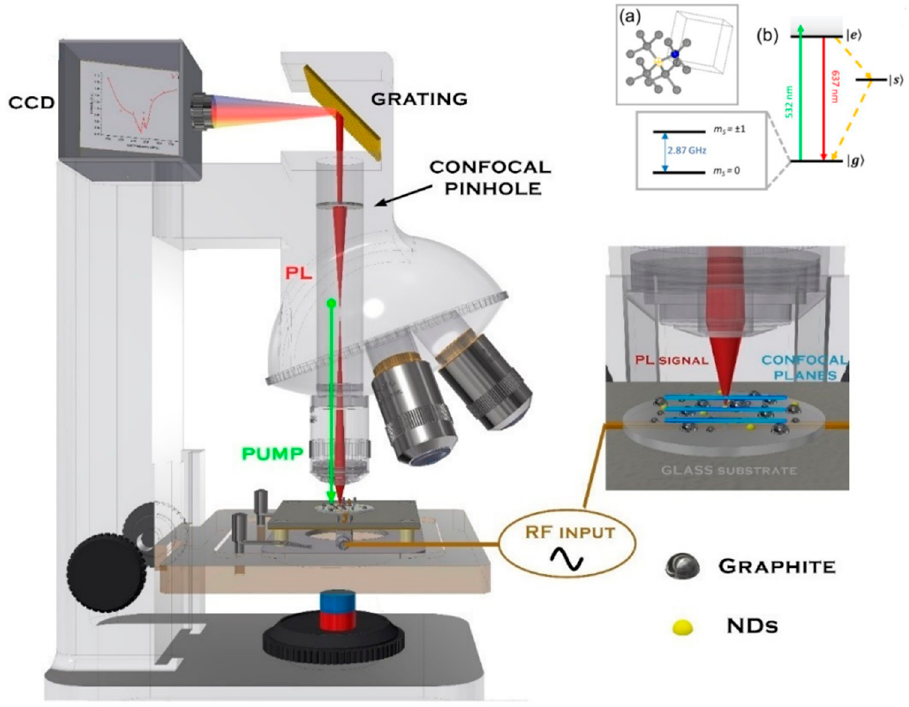
Figure 2. The confocal microscope allowed for the selection of the focal plane of the NDs clusters. The light was spectrally dispersed and finally post-processed in order to get an optically detected magnetic resonance spectrum combined with an optical image of the very region of the sample under investigation. The figure reports the general case when residual graphite is still residually present. Energy levels scheme of NDs are also reported in the top right inset. Section ( a ) shows the NV center crystal structure, and ( b ) the energy levels of the NV color center.